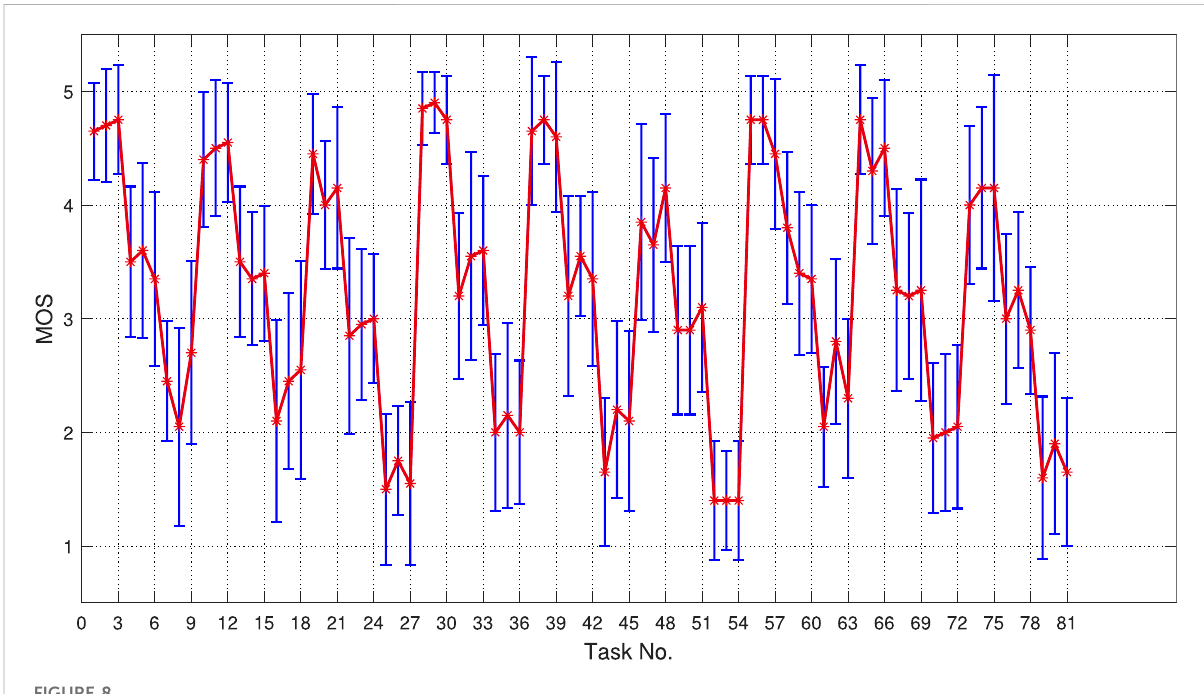
TheobtainedMOSvalueofeachtask(Thehorizontalaxescorrespondstothetasknumber,andtheverticalaxescorrespondstotheMOSvalue. The red star indicates the obtained MOS value. The blue bar indicates the deviation of the subjective scores).